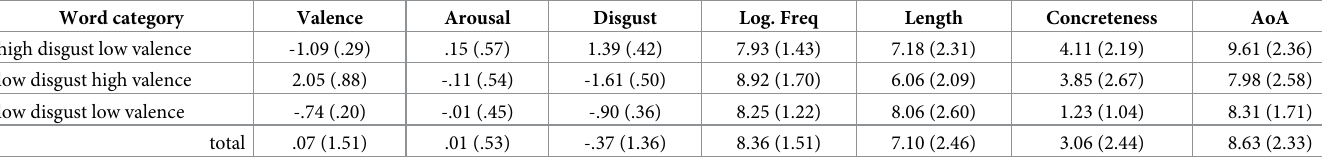
Table 1. Mean characteristics of words by category.